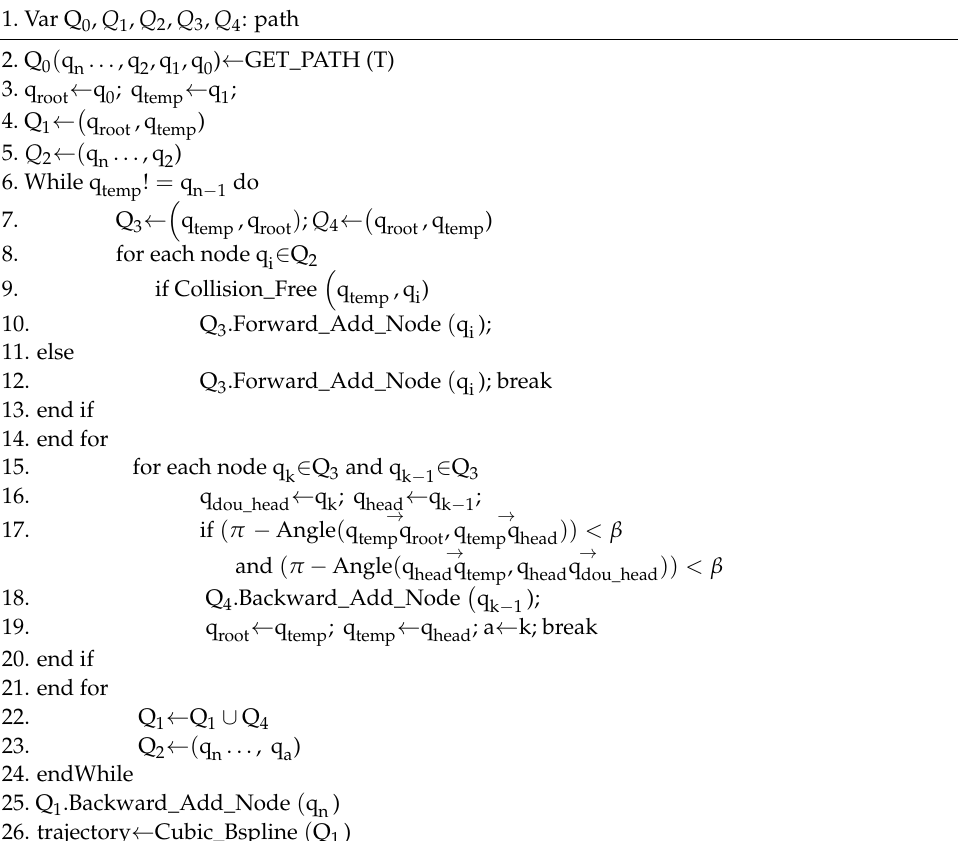
Algorithm 5: Adaptive Improved RRT POST_PROCESSING (